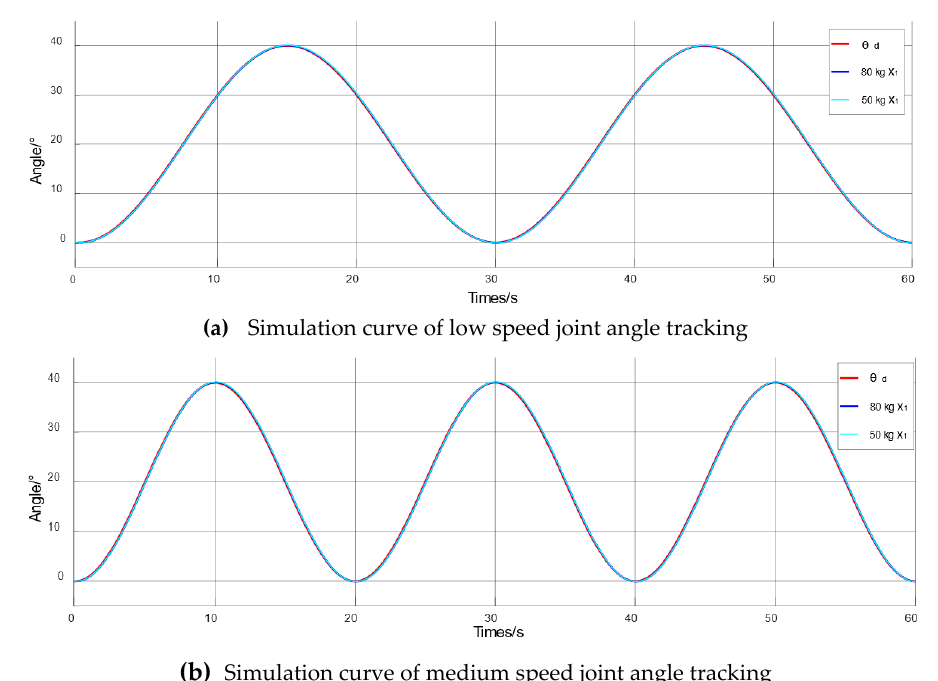
Figure 7. Simulation tracking curve with low, medium, high speed movement.